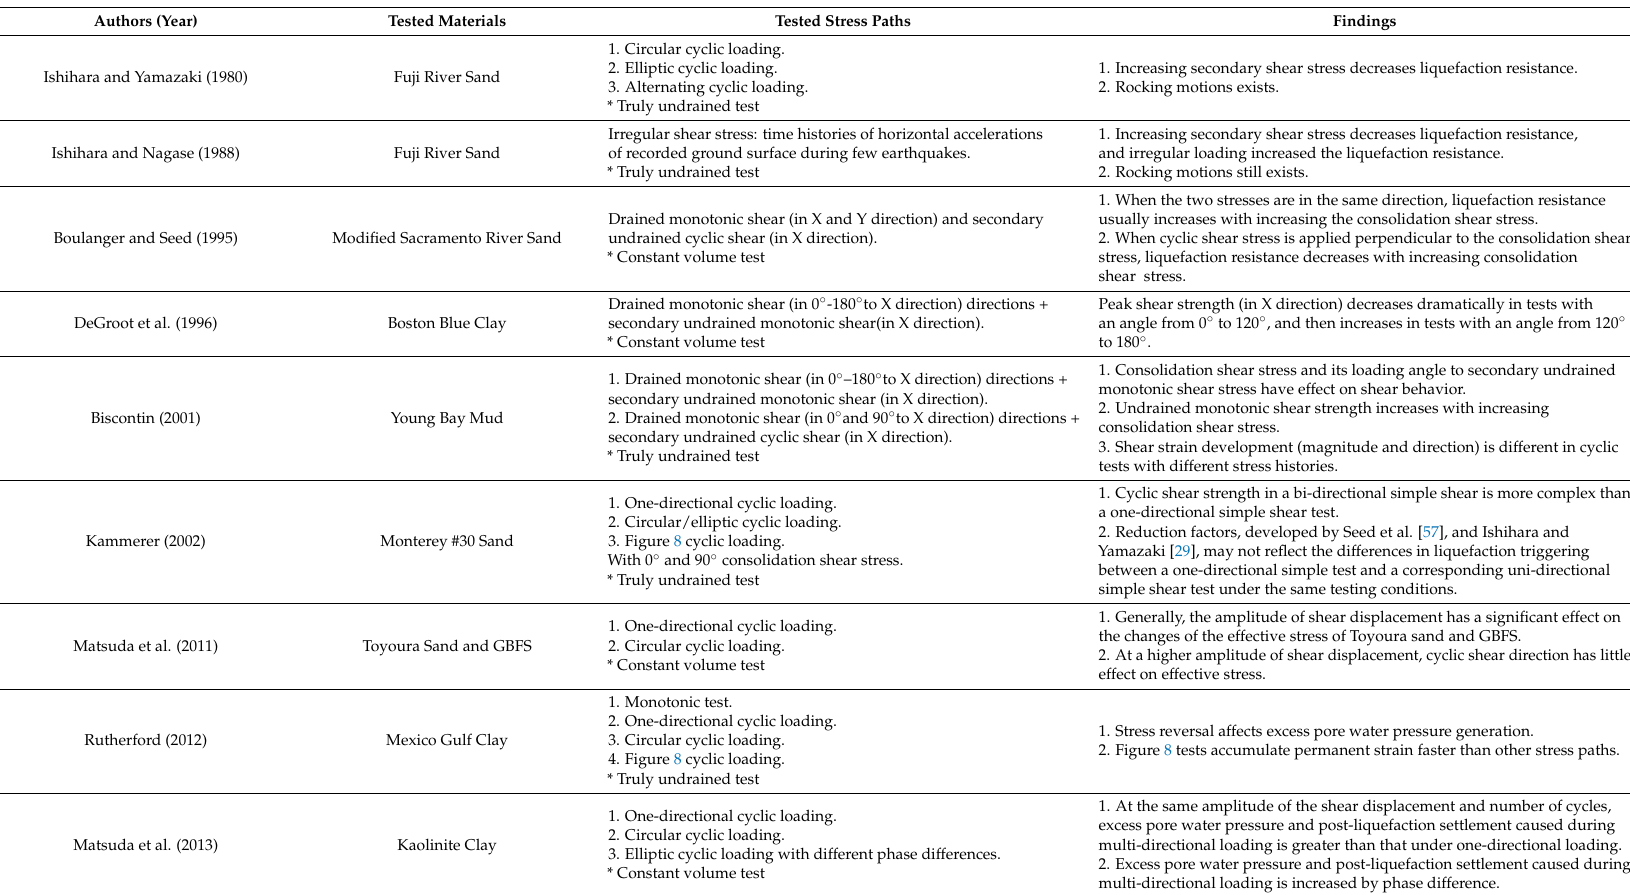
Table 1. Some previous works done by bi-directional direct simple shear